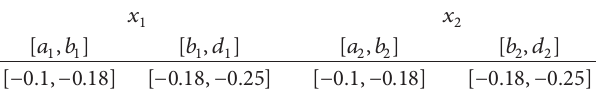
Table5: [𝑎, 𝑏] and [𝑏,𝑑]